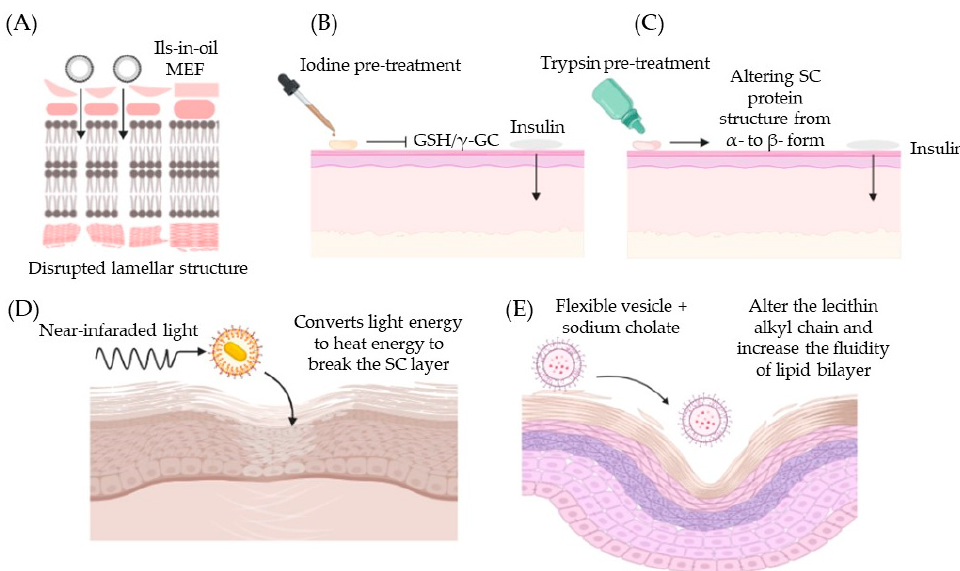
Figure 2. Examples of different types of chemical enhancers and the mechanism of action for the transdermal delivery of insulin. ( A ) Disruption in the lamellar structure of the stratum corneum (SC) was seen with the use of ILs in oil microemulsion (MEF), allowing the permeation of insulin into the skin. ( B ) Pre-treatment of iodine inhibits sulfhydryl compounds such as glutathione (GSH) and gamma-glutamylcysteine ( γ -GC) which then aids the permeation of insulin. ( C ) Pre-treatment with trypsin allows the alteration in the protein structure of the SC from the alpha- to the beta- form allowing the permeation of insulin. ( D ) Gold nanorods (GNRs) based insulin (INS) complex in an oil phase (SO) with the addition of near-infrared light was administered. The complex was then able to absorb light energy to heat energy, breaking the SC layers and allowing the permeation of insulin to the skin. ( E ) A flexible vesicle with the addition of sodium cholate alters the lecithin alkyl chain and increases the fluidity of the lipid bilayer easing the vesicle into the skin.